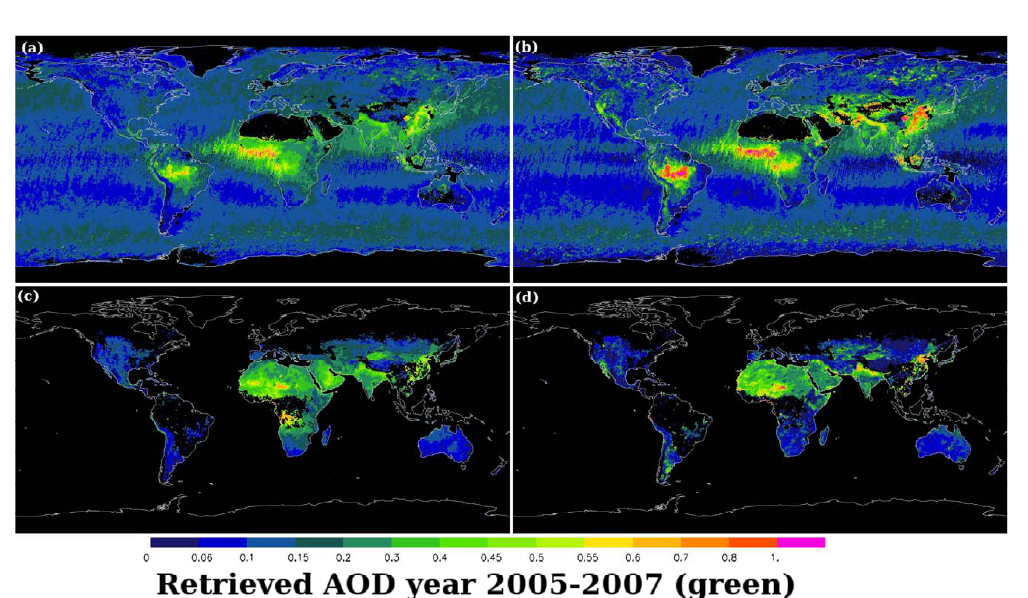
Fig. 2. Average of spatial distribution of MISR (0.558µm) and operational MODIS Dark Target (DT) and MODIS Deep Blue (DB) (0.55µm) for 2005–2007. The MISR and operational MODIS DT/MODIS DB AOD data were first collocated both in space and time, and only collocated MISR and MODIS retrievals were used in generating this plot. Data were gridded every 0.5 ◦ × 0.5 ◦ (Lat/Lon). (a) MISR AOD that corresponds with operational MODIS DT, (b) Operational MODIS DT AOD, (c) MISR AOD that corresponds with MODIS DB, and (d) MODIS DB